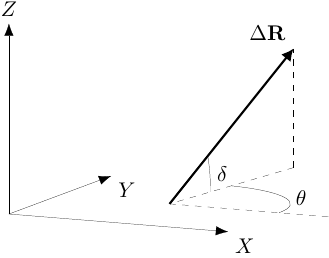
Figure 5. The vector (cid:49) R and its orientation in the state space XYZ , characterizing the stress perturbation imposed on the system by earthquakes produced by neighbouring